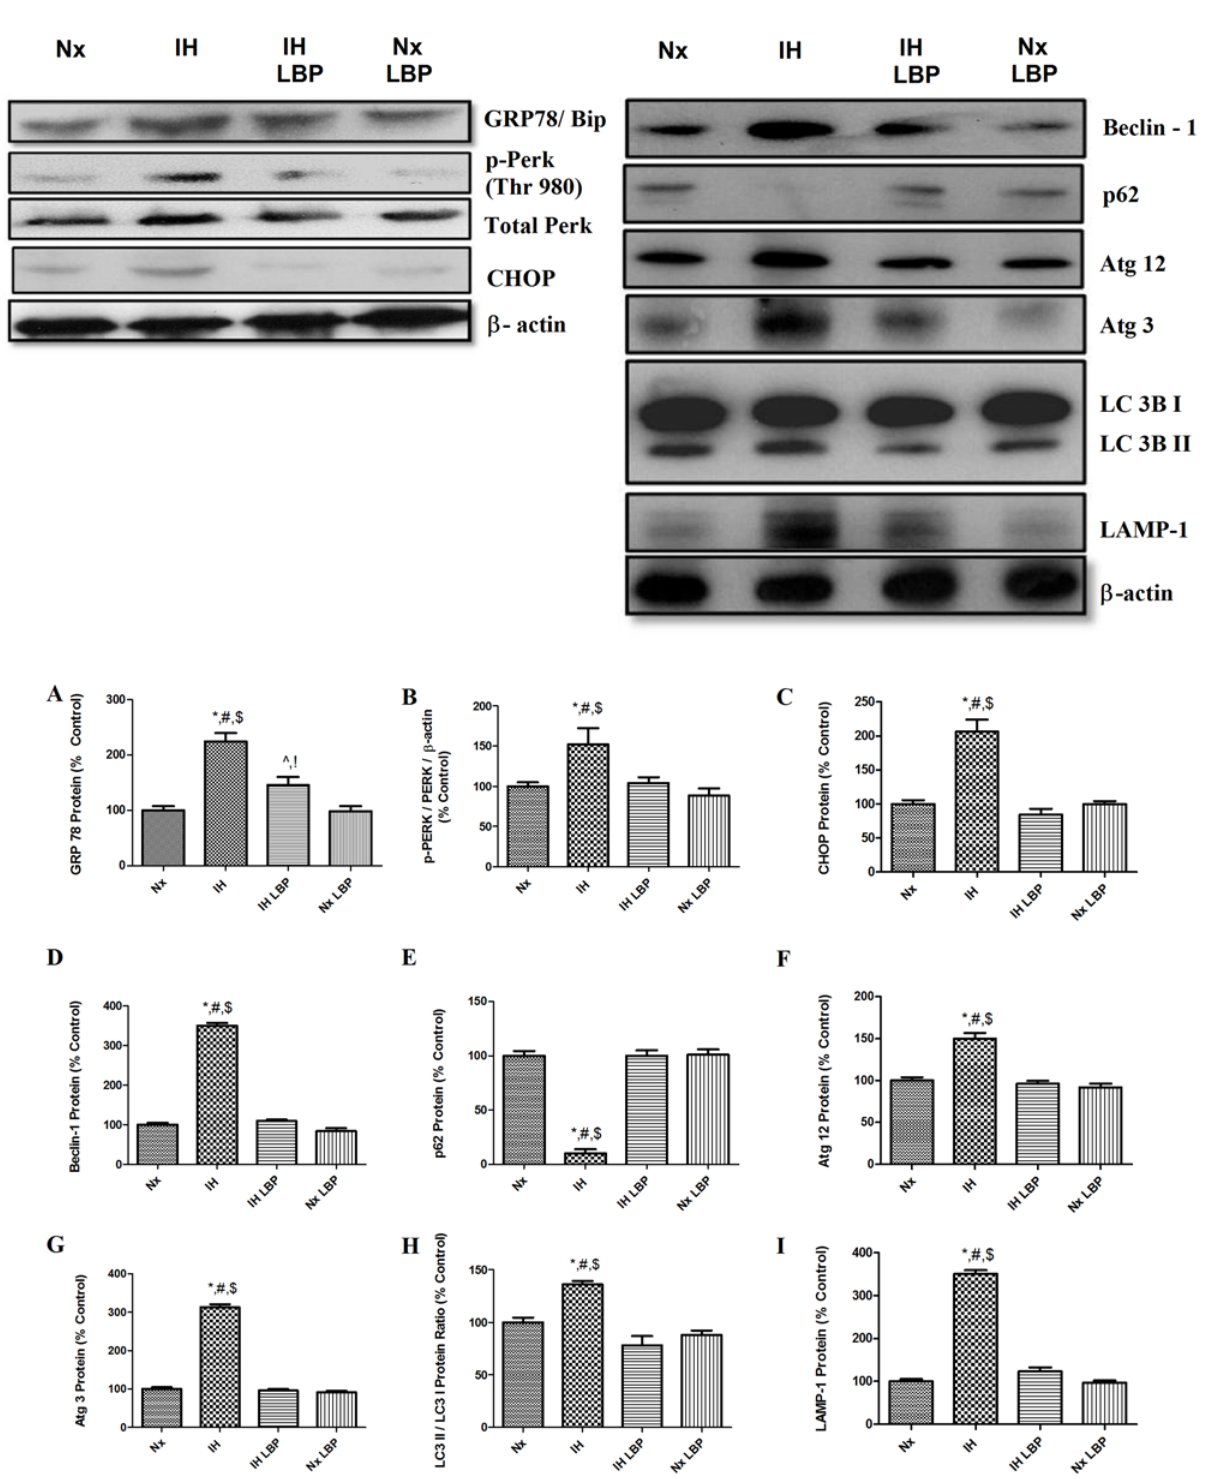
Fig 8. LBP alleviated CIH-induced ER stress in the hippocampus but not through autophagic flux. Levels of the protein expression (upper panel) of (A) GRP78, (B) phosphorylation of PERK, (C) CHOP, (D) Beclin-1, (E) p62, (F) Atg12, (G) Atg3, (H) LC3 II/I ratio and (I) LAMP-1 in the hippocampus of the normoxic (Nx) or hypoxic (IH) groups; LBP-treated hypoxic (IH+LBP) or normoxic (Nx+LBP) groups are summarized. β -actin was an internal control. Data are mean ± SEM (n = 6 – 8). For GRP78, * p < 0.05 when compared with Nx, # p < 0.05 when compared with IH+LBP, $ p < 0.05 when compared with Nx+LBP groups, ^ p < 0.05 when compared with Nx, ! p < 0.05 when compared with Nx+LBP. For p-PERK, CHOP, Beclin-1, p62, Atg12, Atg 3, LC3II/I and LAMP-1, * p < 0.05 when compared with Nx, # p < 0.05 when compared with IH+LBP, $ p < 0.05 when compared with Nx+LBP